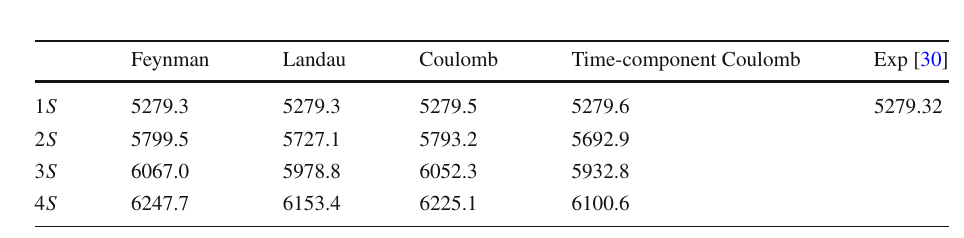
Table 4 Mass spectra of B